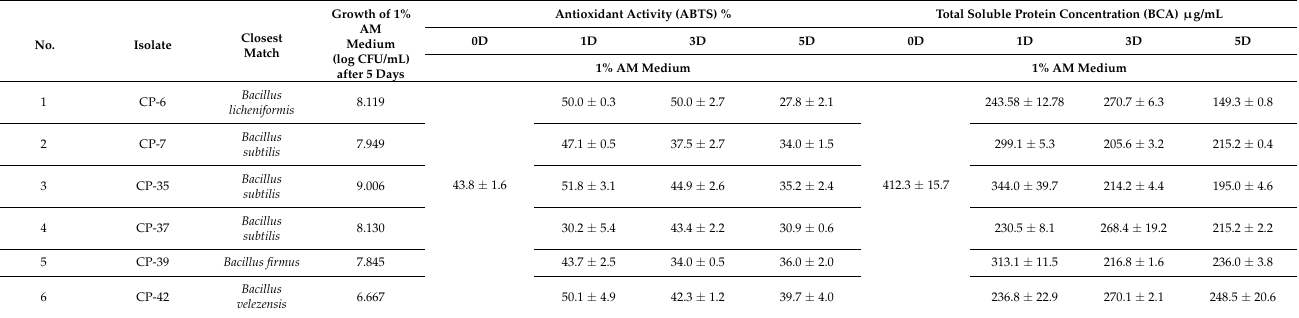
Table 1. Antioxidant activity of six strains that showed growth of 1% Abelmoschus manihot medium.